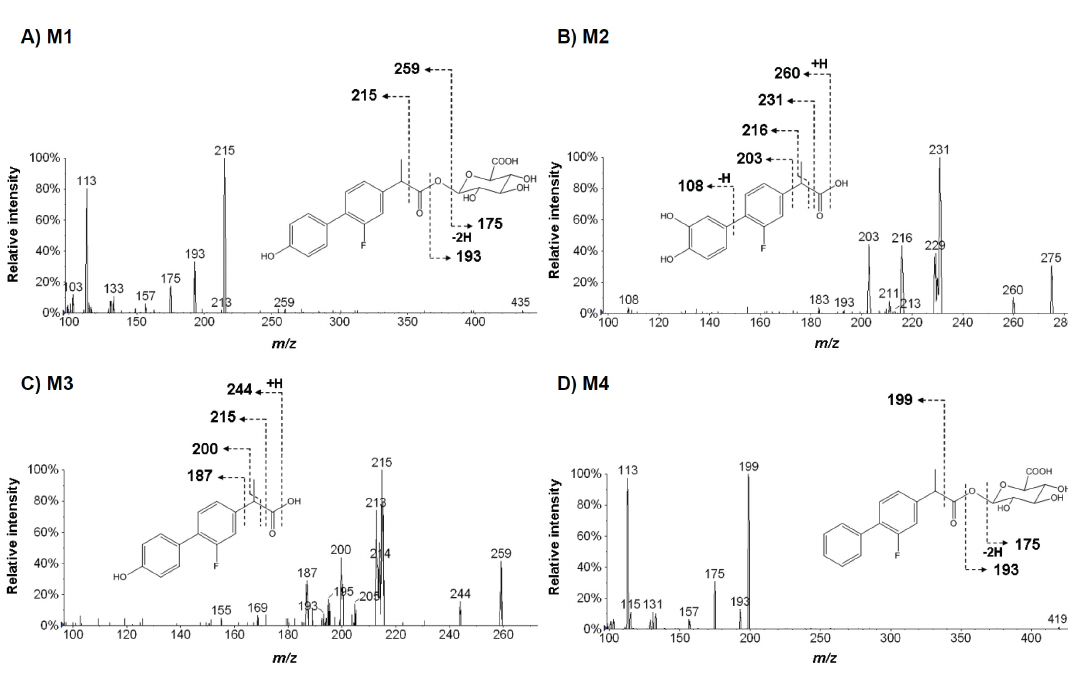
Figure 7. Representative MS/MS spectra of four flurbiprofen metabolites and their estimated chemical structures. Precursor ions were m/z 435 ( A ), 275 ( B ), 259 ( C ), and 419 ( D ) with the positive ion mode. Each arrow indicates a possible site of fragmentation, with the corresponding